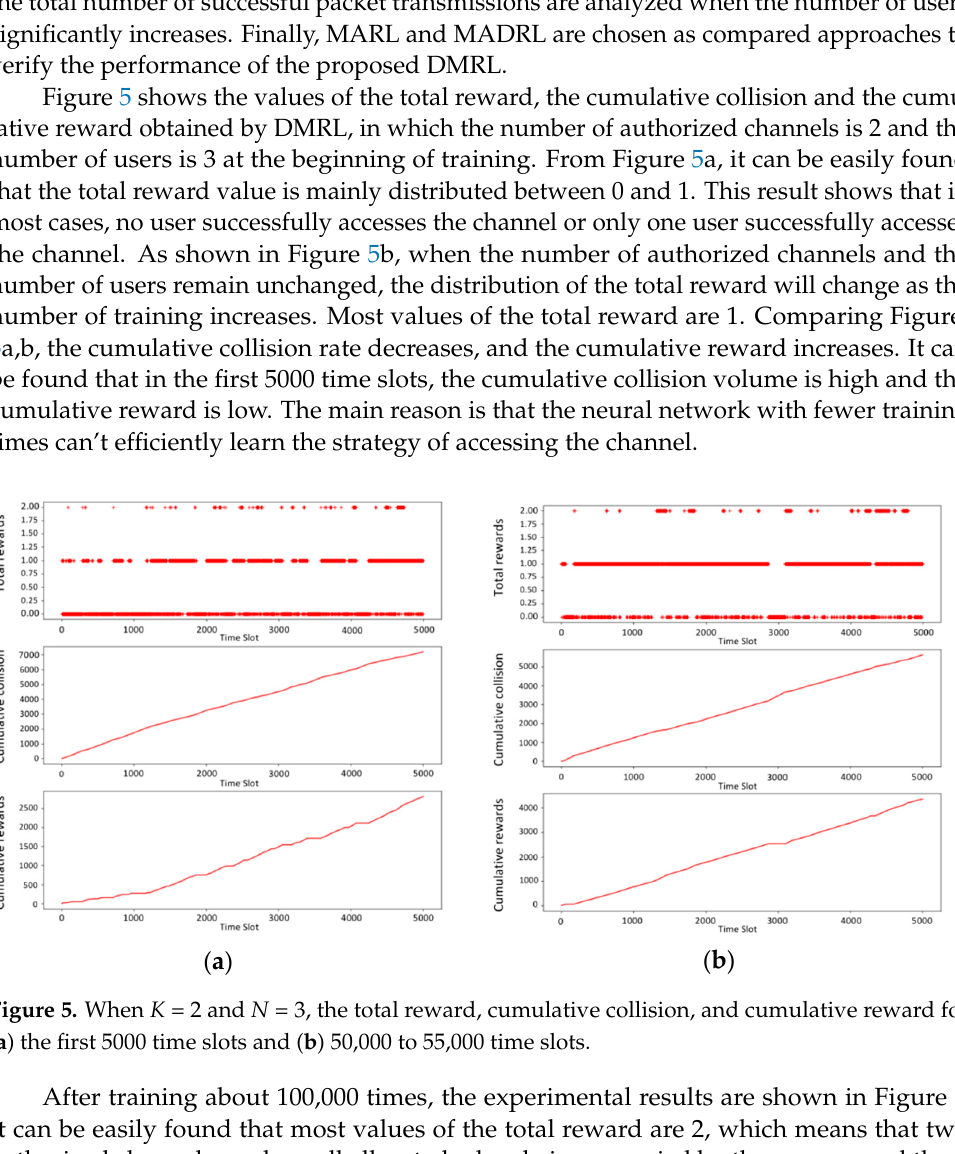
Figure 6. When K = 2 and N = 3, the total reward, cumulative collision, and cumulative reward for the last 5000 time slots. Figure 7 shows the scenario with 6 authorized channels and 10 users. It can be easily observed that the total reward increases as the increase in training slots, i.e., the reasonable number of authorized channels is increased, but the rate of increase is not fast. It can be obviously found from Figure 7a that the total reward value is roughly dis ‐ tributed around a lower value at the beginning of training, and the cumulative collision volume remains in a high ‐ value range. However, the total cumulative reward remains in a low range. The reason is the same, i.e., too few channel perception records are used to train the neural network. As can be seen in Figure 7b, as the number of training increases, the multi ‐ user cooperative sensing strategy learned by the neural network becomes more and more accurate, and the total reward value gradually increases, but the degree of op ‐ timization is relatively slow. However, the cumulative collision volume is still not low. This is because the increase in the number of authorized channels and the number of sec ‐ ondary users will increase the state space, and more difficult problems will take longer to resolve. When the number of training reaches a certain level, the experimental results are